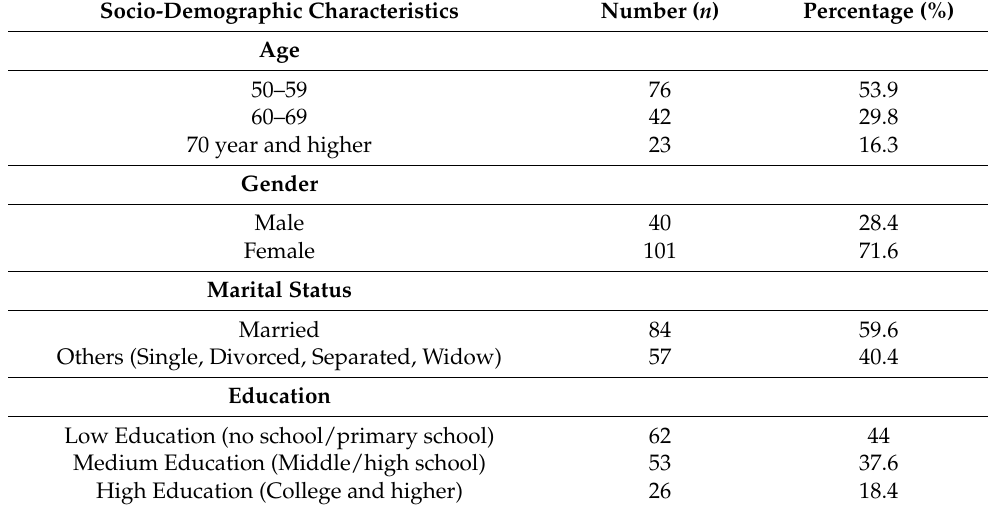
Table 2. Percentage of the sample